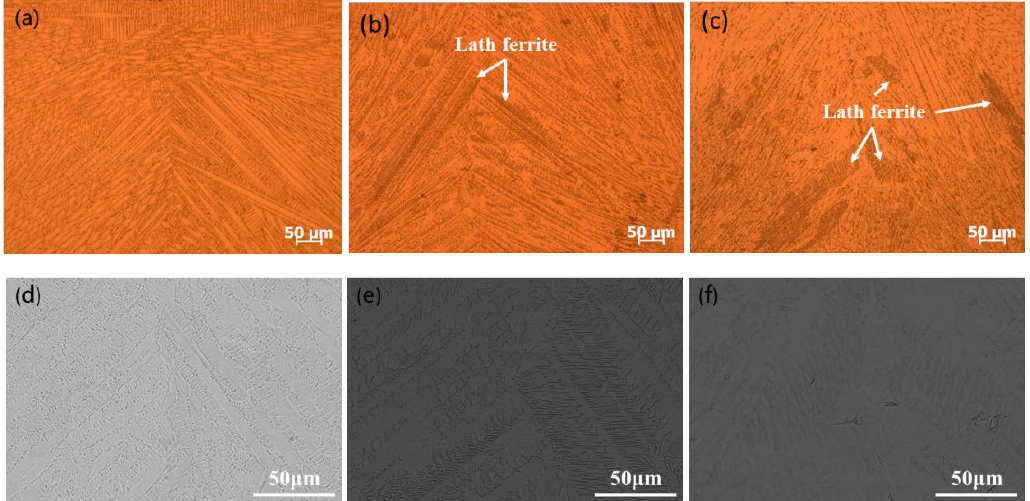
Figure 10. Optical microscope (OM) and scanning electron microscope (SEM) images of the microstructure of the cross-section of the weld joint during laser welding at a welding speed of 1.0 m / min. ( a ) OM image in SUS310; ( b ) OM image in SUS316; ( c ) OM image in SUS304; ( d ) SEM image in SUS310; ( e ) SEM image in SUS316; ( f ) SEM image in SUS304 .